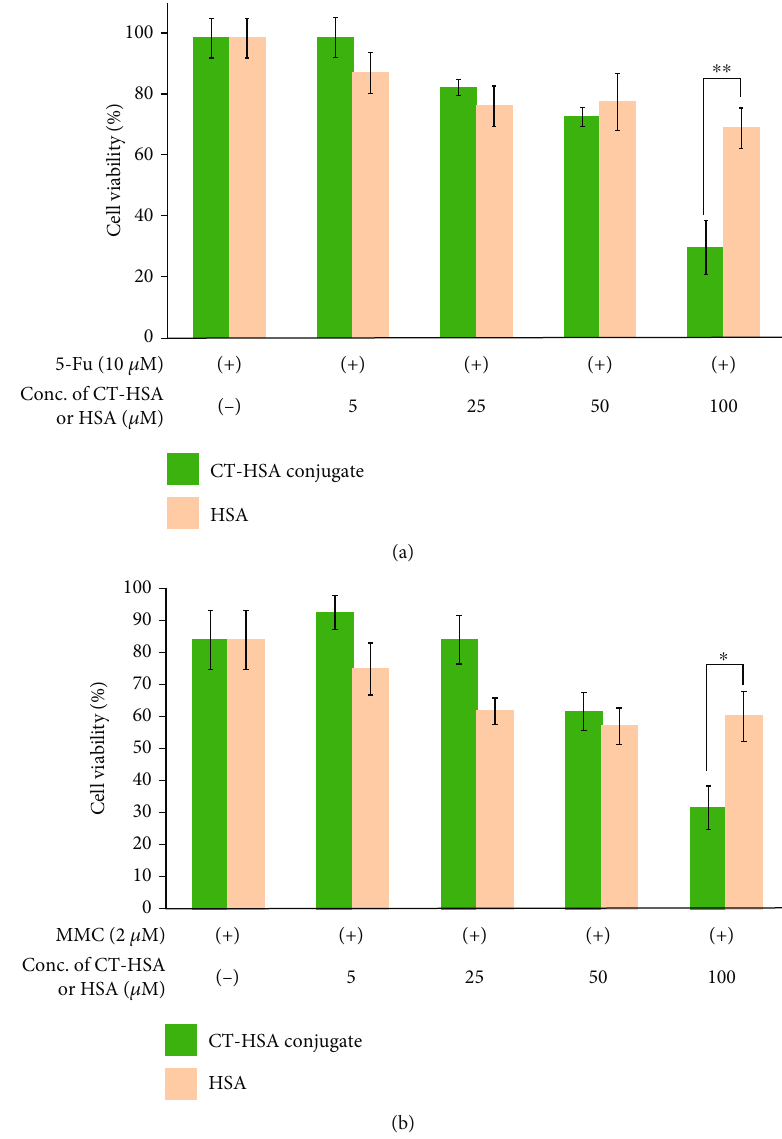
Figure 6: Cytotoxic e ff ect of the CT – HSA conjugate or HSA as a drug carrier on HeLa cells. HeLa cells were treated with the CT – HSA conjugate (0-100 μ M) or HSA (0-100 μ M) mixed with (a) 10 μ M 5-Fu and (b) 2 μ M MMC. Di ff erences between each concentration of the sample and the control were analyzed by t -test ( mean ± SD , n = 5 ); ∗ p < 0 : 01